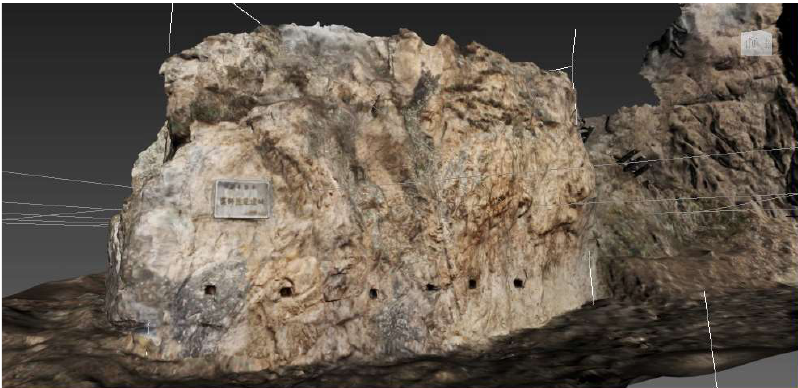
Figure 5. Three-dimensional model of the existing Chiya Plank Road Site.